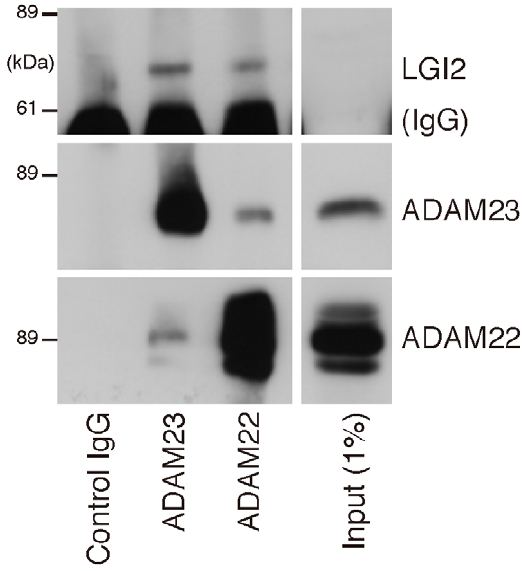
Figure 5. LGI2 interacts with ADAM22 and ADAM23 in rat brain. Western blotting shows that antibodies against ADAM22 or ADAM23 co-precipitate Lgi2 in brain lysates.